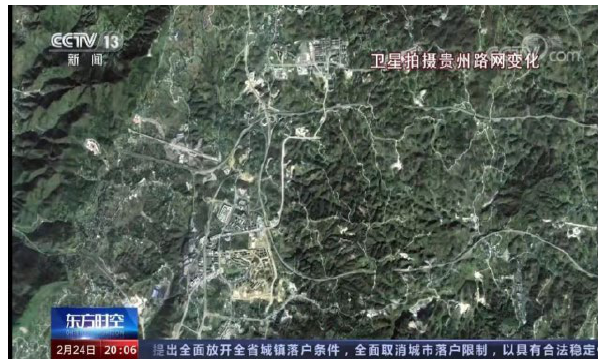
Figure 7. The real-time service of massive remote sensing image